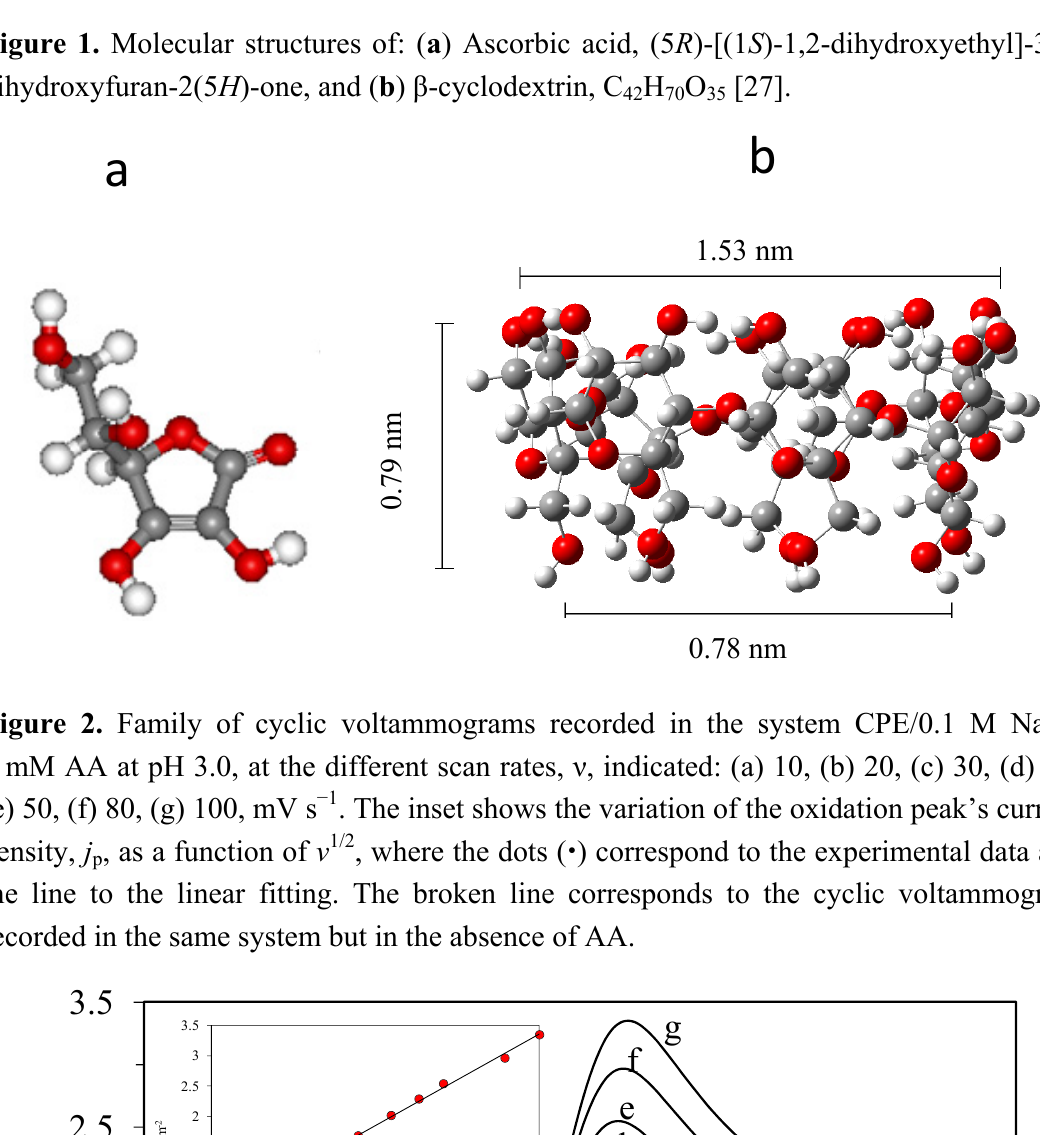
Figure 1. Molecular structures of: ( a ) Ascorbic acid, (5 R )-[(1 S )-1,2-dihydroxyethyl]-3,4- dihydroxyfuran-2(5 H )-one, and ( b ) β -cyclodextrin, C